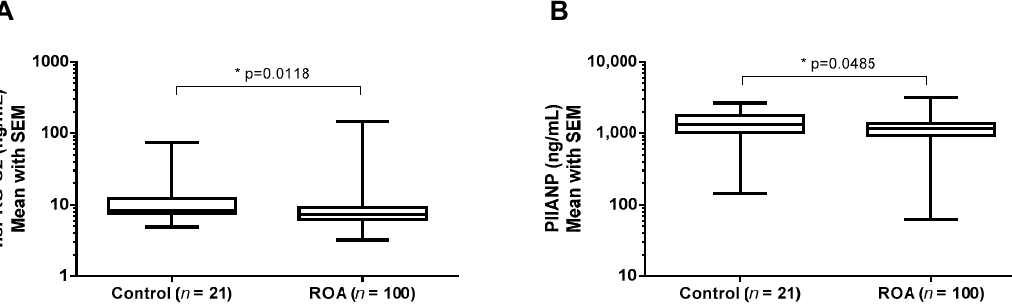
Figure 4. Serum type IIB collagen NH 2 -propeptide (PIIBNP) ( A ) and type IIA collagen NH 2 -propeptide (PIIANP) ( B ) were determined in healthy subjects and osteoarthritic patients. Control group: Kellgren-Lawrence (KL) = 0 and 1, n = 22; Radiographic osteoarthritis (ROA) group: KL = 2, 3 and 4, n = 123. Black horizontal lines are means, and error bars are standard error of the mean (SEM). The nonparametric Mann–Whitney test was used to compare each group. * p < 0.05.